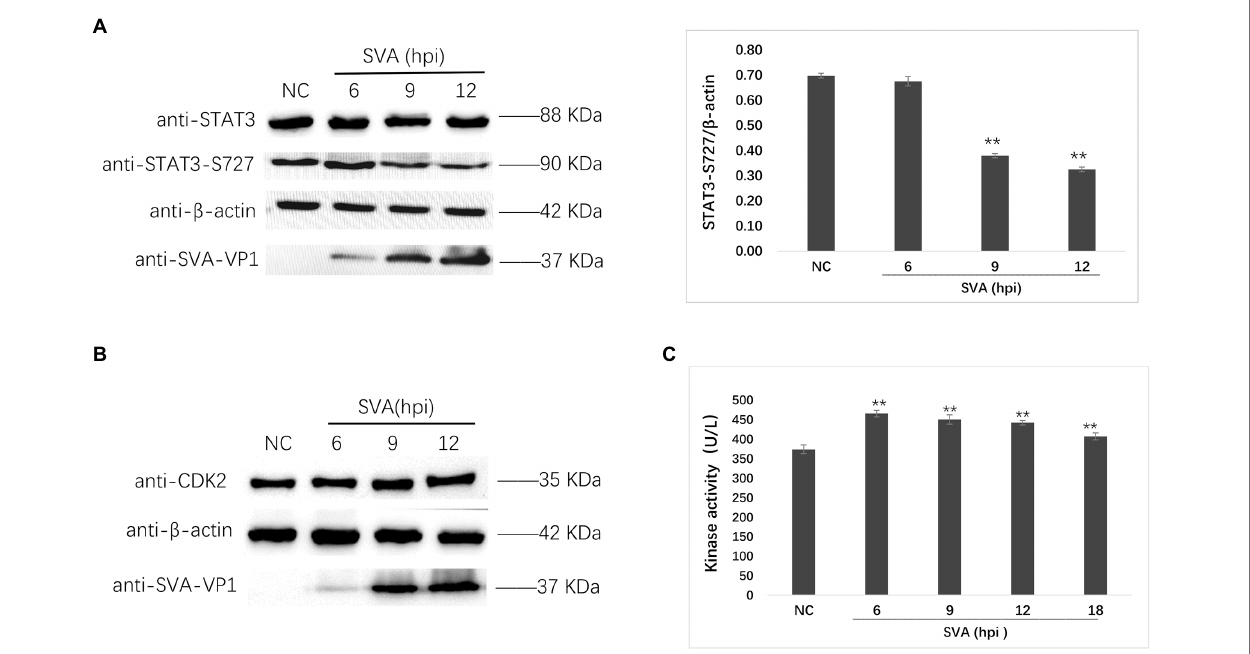
FIGURE 8 | Verification of the phosphoproteomics results by Western blot and kinase activity detection. (A) Western blot detecting the expression of STAT3 and the phosphorylation of STAT3-S727 at 6, 9, and 12 hpi of SVA infection. The relative expression of STAT3-S727 was determined by comparing the STAT3-S727/ β - actin area value. (B) The expression of CDK2 at 6, 9, and 12 hpi of SVA infection. (C) The kinase activity of CDK2 at 6, 9, 12, and 18 hpi of SVA infection. The statistical significance is shown by ** for p <